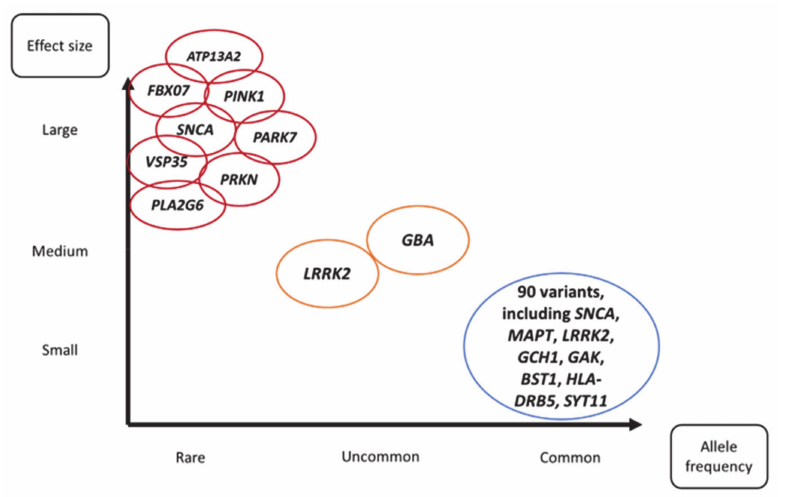
Figure 1. Summary of genetic variants in Parkinson’s disease grouped according to allele frequency and associated risk of Parkinson’s